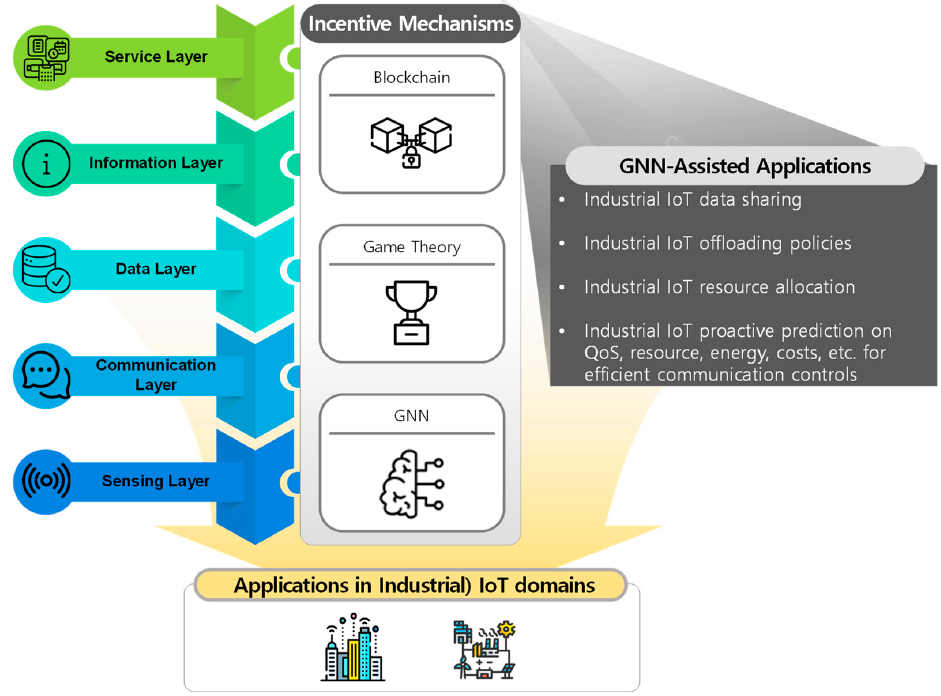
Figure 6. Incentive mechanisms with GNNs for non-Euclidean data in communication/data layers.